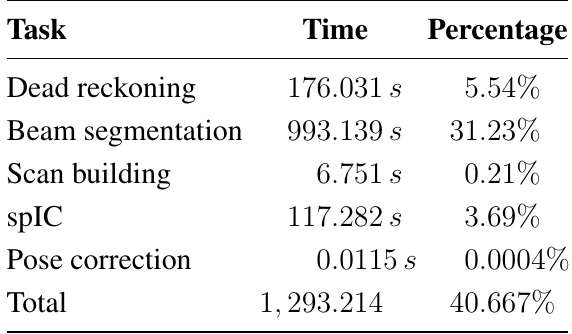
Table 4. Time consumption for each task involved in uspIC. The percentages denote the fraction of time of the whole mission execution corresponding to each